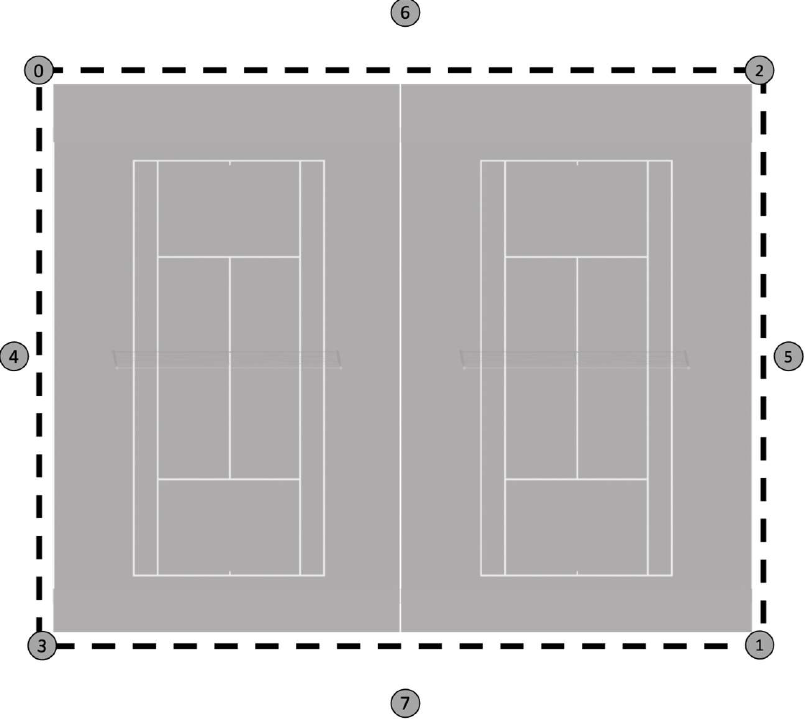
Figure 1. The ultra-wideband reference system used during the study.